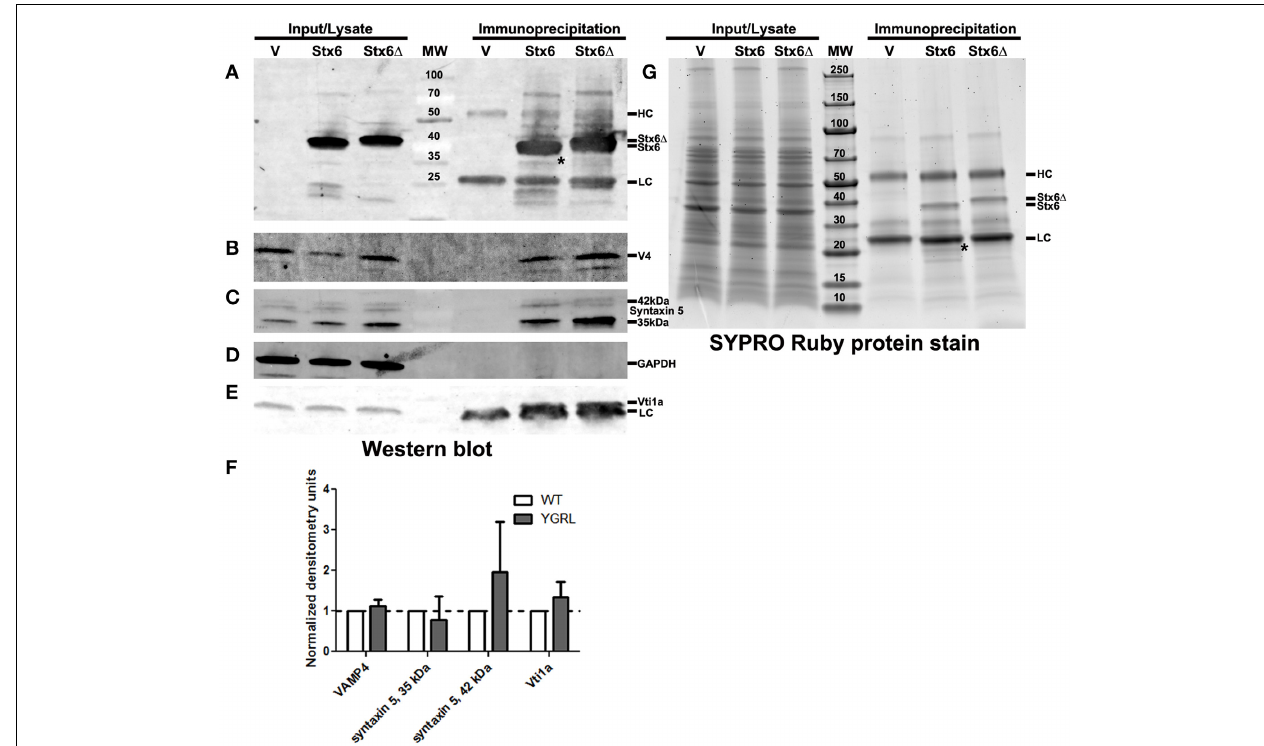
FIGURE 5 | Immunoprecipitation analysis of syntaxin 6 and syntaxin 6 (cid:2) YGRL. Lysates from transfected and C. trachomatis infected HeLa cells were immunoprecipitated with anti-FLAG M2 antibody. The input and immunoprecipitates were resolved by SDS-12%PAGE and blotted with antibodies against FLAG M2 (A) , VAMP4 (V4) (B) , syntaxin 5 (C) , GAPDH (D) , and Vti1a (E) . Densitometry values of eluates of each protein were normalized to input bands and the amount of 3XFLAG-syntaxin 6 (Stx6) or 3XFLAG-syntaxin 6 (cid:2) YGRL (Stx6 (cid:2) ) eluates. The normalized values are expressed as a ratio to Stx6 eluates (set at 1) and the resulting graph